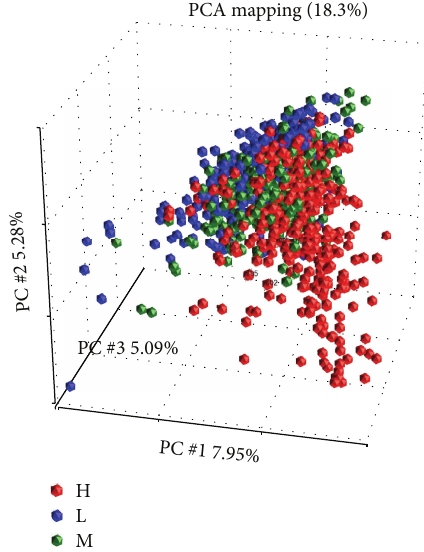
Figure 1: Principle component analysis (PCA) of all samples. then performed a hierarchical clustering (Figure 2) using log2-transformed normalized signal intensities. The observed separation of samples in each group (SEMA6D-high, SEMA6D-medium, and SEMA6D-low) indicates different expression profiles among these groups.